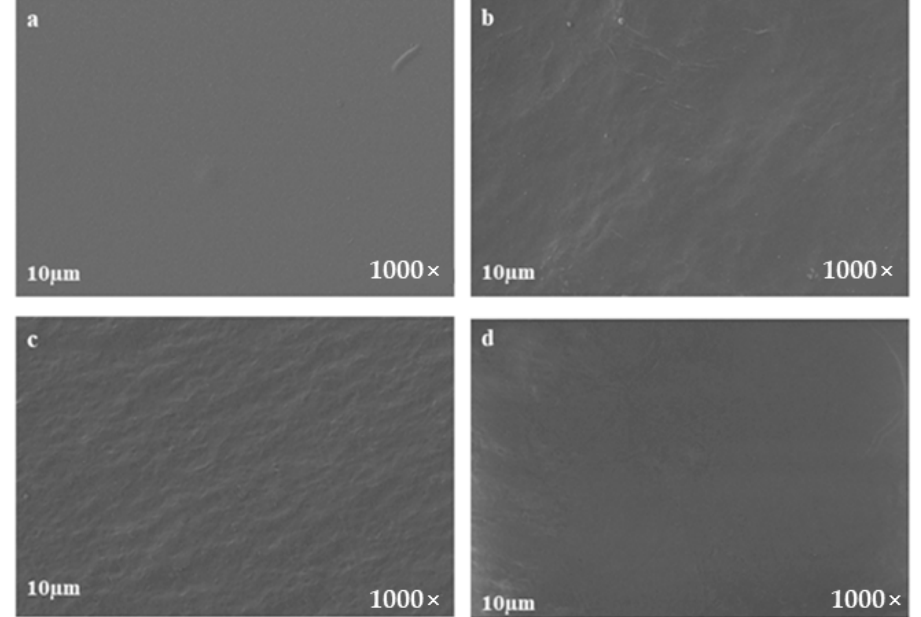
Figure 12. SEM images of cellulose(H)- g -PNIPAAm-Br films: ( a ) cellulose pulp film; ( b ) cellulose(M)- g -PNIPAAm-Br film; ( c ) cellulose(H)- g -PNIPAAm-Br film; ( d ) 50 wt% cellulose pulp + 50 wt% cellulose(H)- g -PNIPAAm-Br film. All images were taken at a ×1000 magnification.